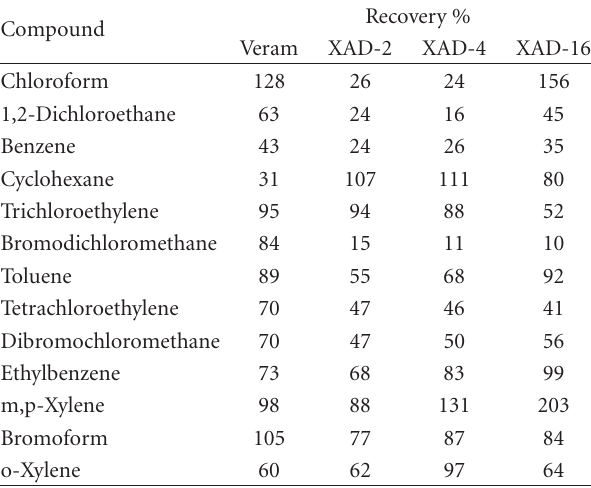
Table 3: VOCs recovery values expressed in % of signals found for deployed membranes as compared with spiked ones obtained for di ff erent adsorbents ( c = 150ng · sampler − 1